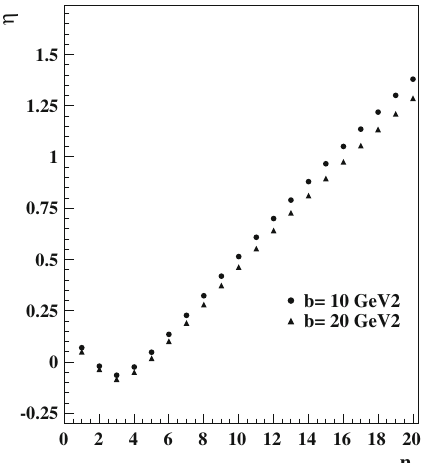
Fig. 9 η − n relation as computed from the parameters A , B , C of the ABC fit